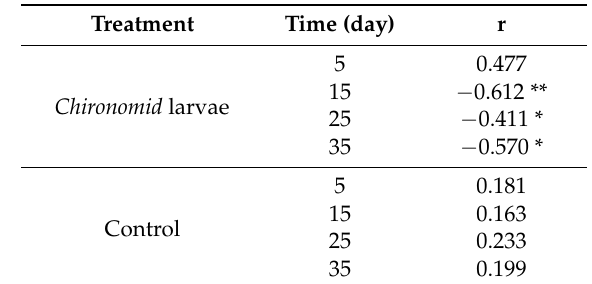
Table 2. Correlation analyses between NH 4 + and NO 3 − profiles in pore water of the control and the Chironomid larvae treatment ( p = 0.05).